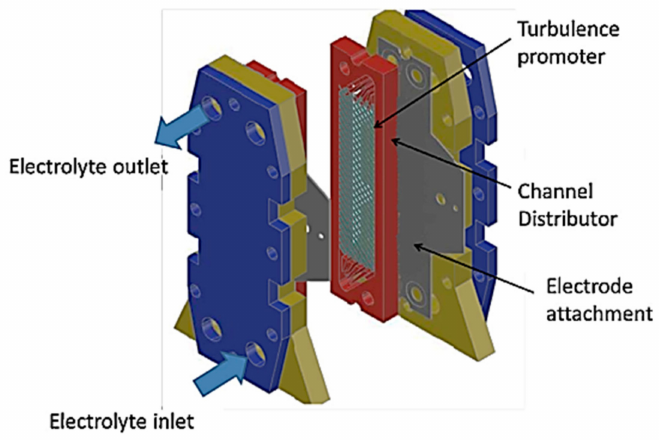
Figure 8. The FM01-LC electrochemical reactor